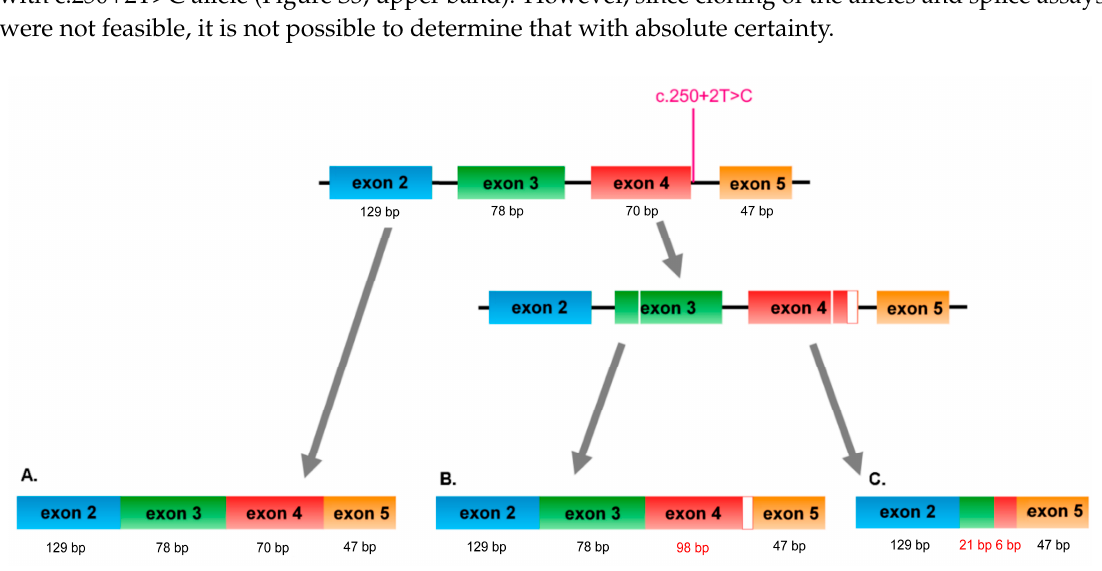
Figure 2. Splicing variants discovered in the proband. A. Normal transcript probably produced from both wild-type and c.250+2T>C allele. B. Longer transcript due to alternative splice site